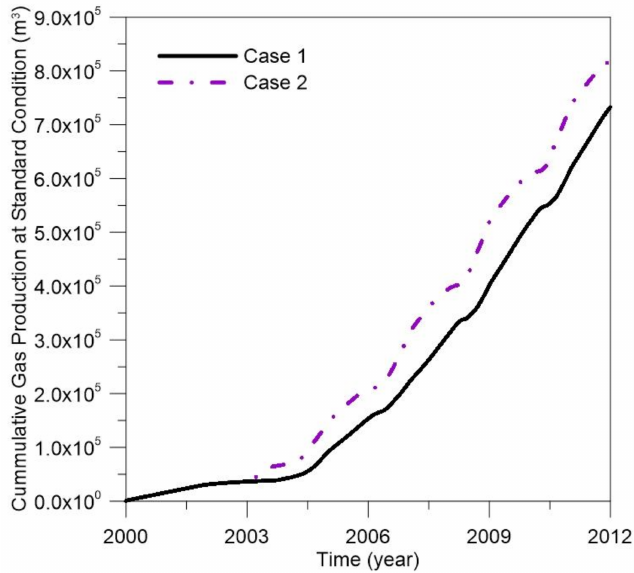
Figure 6. Cumulative gas production during the CO 2 and impure CO 2 WAG injection under standard conditions.